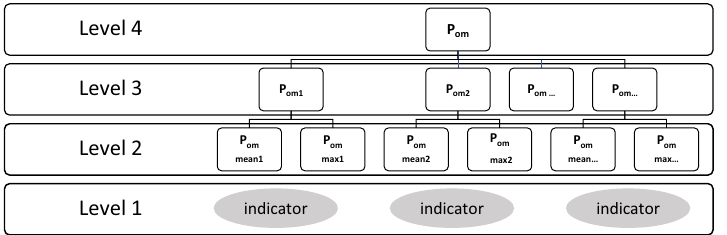
Figure 1. Hierarchical Approach for assessing Probability of Misclassification for the chemical status for a water body. Level 1 consists of classified chemical quality indicators ( good or below good status class); Level 2 consists of P om s for the class of each indicator; there are separate P om s for the mean and max criterion; Level 3 represents eventual P om values for all chemical indicators; and Level 4 is the final P om for chemical